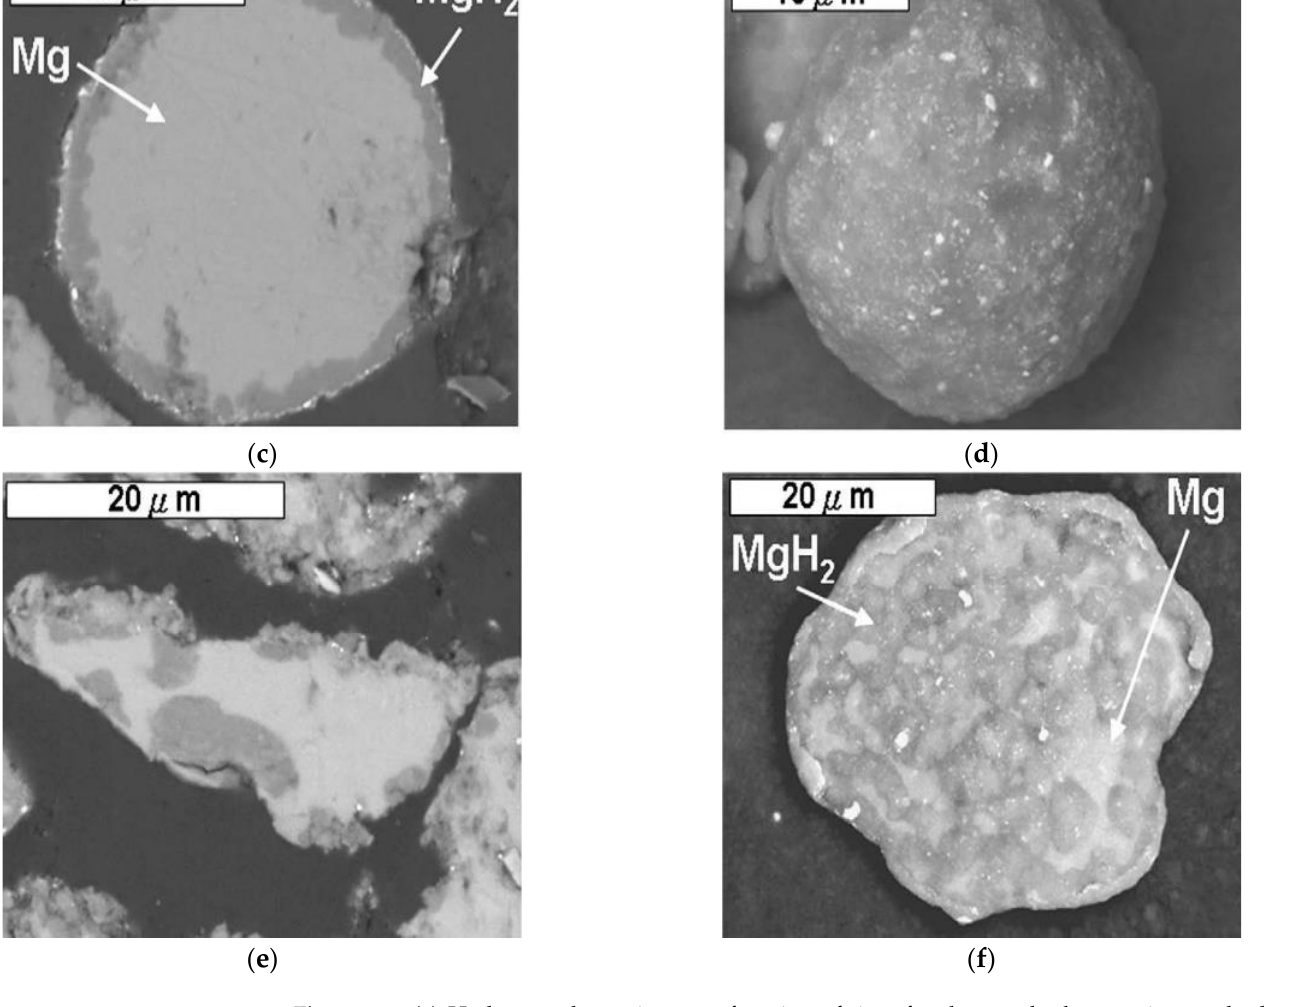
Figure 11. ( a ) Hydrogen absorption as a function of time for the two hydrogenation methods employed; ( b ) A scheme of the influence of temperature and hydrogen pressure on the nucleation rate of MgH 2 during the hydrogenation of Mg. SEM pictures comparing the hydride formation behavior for powders hydrogenated by Method I for 75 min (( c , d ) and by Method II for 3 min ( e , f )). ( c , e ) are the cross-sectional views, and ( d , f ) are the external views of the powders